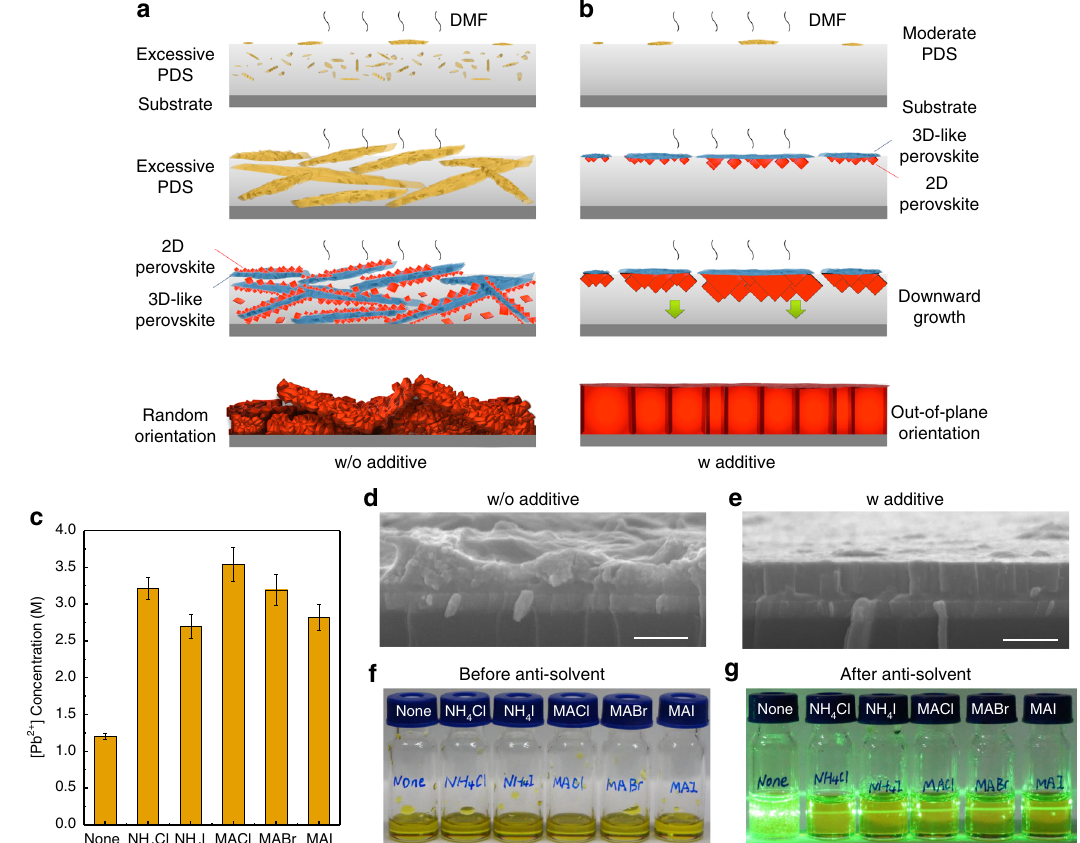
Fig. 3 Competition of crystal growth models and suppressed nucleation by AX salts. a , b Illustration of the 3D-like perovskites de fi ned nucleation and growth of RP crystals from precursor solution without ( a ) or with ( b ) excessive AX additives; c in fl uence of the AX additives (AX/PbI 2 = 0.5) on the critical concentration of precursor solution for the nucleation of PbI 2 -DMF solvated phase in DMF, the error bars represent the s.d. of three measurements; d , e cross-sectional SEM images of BA-based RP perovskite fi lms spun from precursor solution (< n > = 4) without ( d ) or with ( e ) NH 4 Cl additives. The scale bar is 500 nm; f photos of BA-based RP perovskite precursor solutions (< n > = 4, 210 μ L) without additive or with AX additives (AX/PbI 2 = 0.5) before the injection of chlorobenzene; g precursor solutions after injecting 540 μ L CB as antisolvent, in which the precipitation of PDS was suppressed in the solutions with AX additives, as indicated by Tyndall